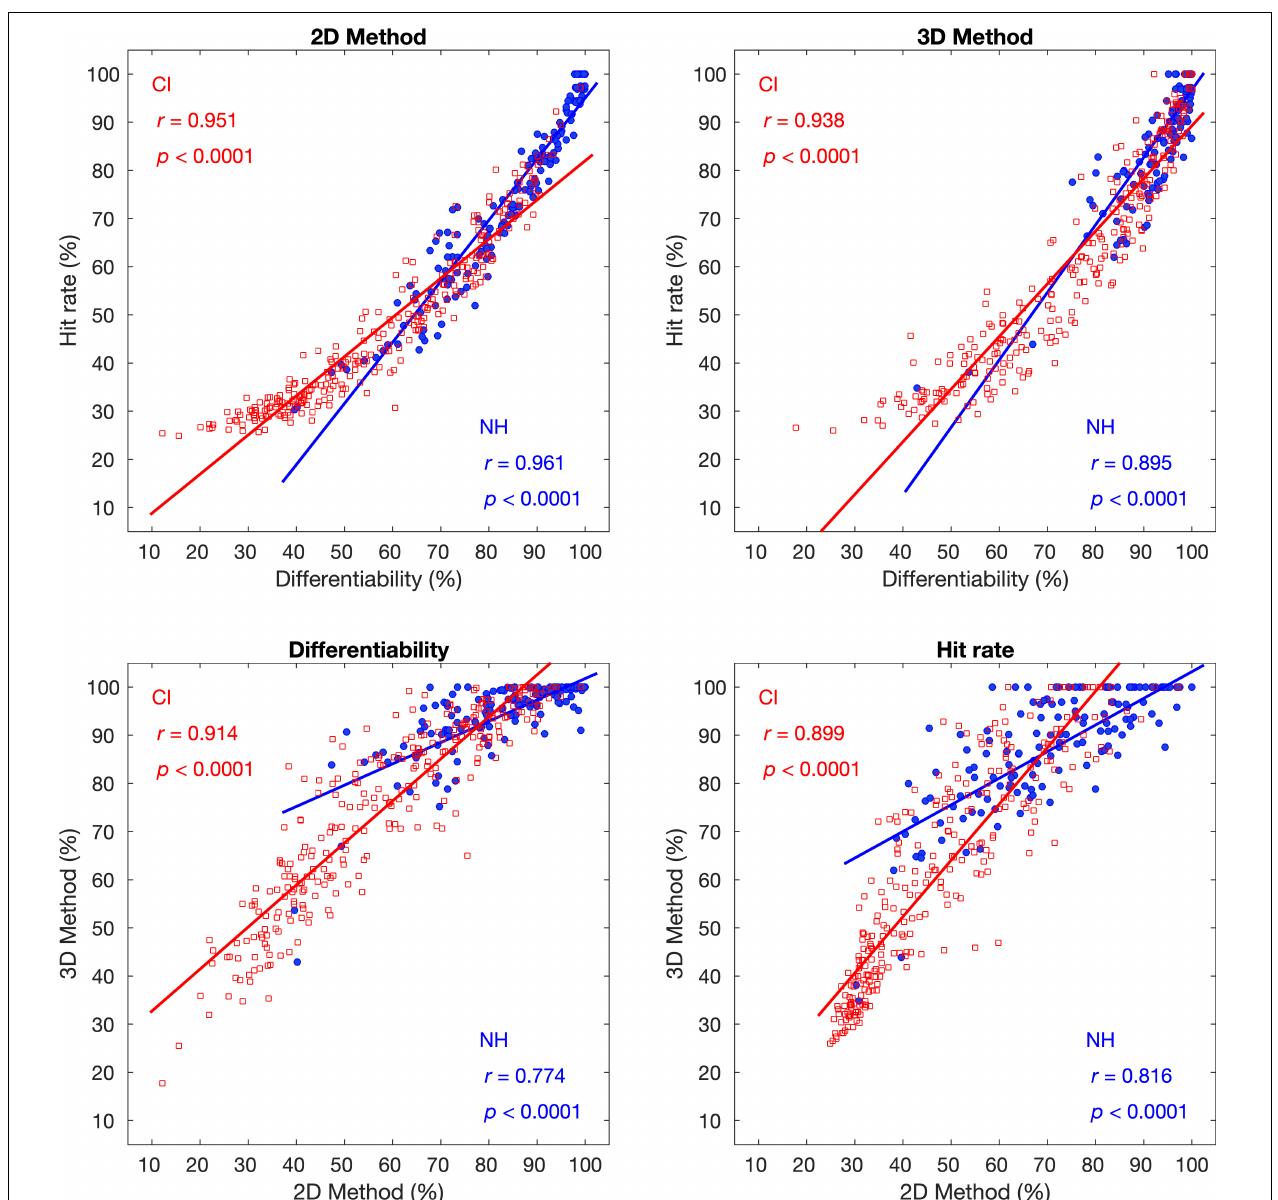
FIGURE 5 | Upper panels: Correlation between averaged tone differentiability and tone hit rate in the 2D (left) and 3D methods (right) . Lower panels: Correlation between the 2D and 3D methods in tone differentiability (left) and hit rate (right) . In each panel, each symbol represents one subject. Red open symbols represent subjects in the CI group, and the filled blue symbols represent subjects in the NH group. Red and blue lines are the linear fit of the CI and NH group data, respectively. Correlation coefficient r and the corresponding p -value for the CI group are shown on the upper left corner, and those for the NH group are shown in the lower right